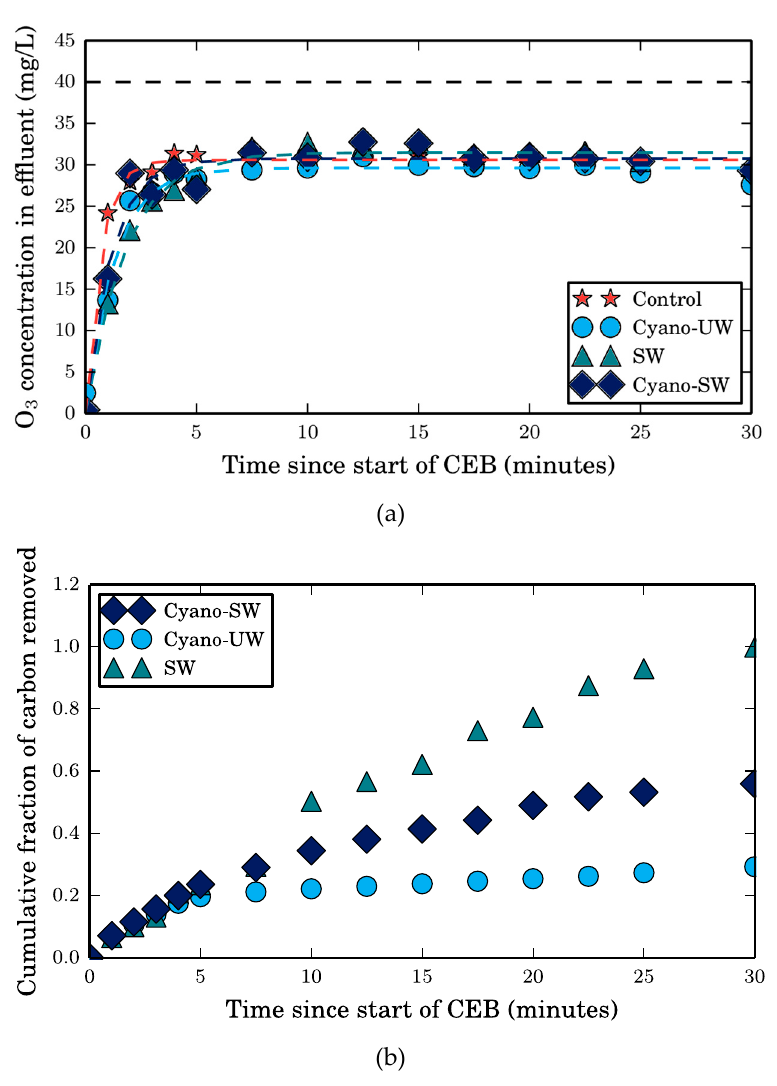
Figure 7. ( a ) Residual ozone concentration and ( b ) accumulated TOC in effluent at different times throughout a 30-min ozone CEB. The dissolved ozone concentration in the CEB influent was maintained at 40 mg/L, as indicated by the dashed horizontal line in Figure a. The CEB flux was approximately 600 LMH.